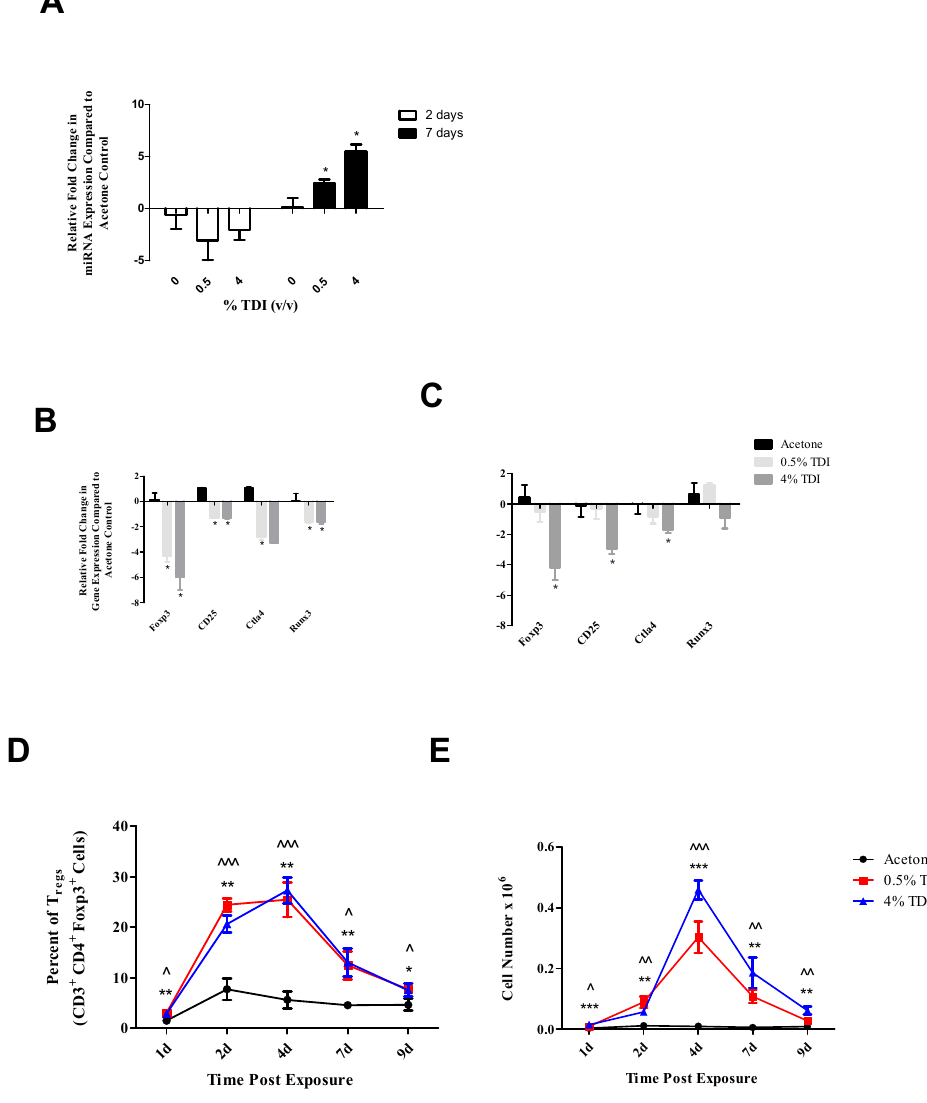
Figure 4. Mature miRNA and Runx3 expression increases in T regs during TDI sensitization. RT ‐ PCR analysis of miR ‐ 210 ( A ) and T reg ‐ related gene expression in the dLN T reg subset at two ( B ) and seven days ( C ) post TDI exposure. T regs were isolated as CD4 + CD25 + cells and cellular purity was assessed via flow cytometric staining for CD3 + CD4 + Foxp3 + events (2 days: % T regs of all CD4 + events, mean, n = 4–5 per group: Acetone: 83.8% ± 1.6%, 0.5% TDI: 67.1% ± 4.2%, and 4% TDI: 72.3% ± 1.9%; 7 days: % T regs of all CD4 + events: Acetone: 91%, 0.5% TDI: 88.4%, and 4% TDI: 86.7%). Flow cytometric analysis of dLN Runx3 + T reg frequency ( D ) and number ( E ) following TDI sensitization. Bars represent mean relative fold change (±SE) of 4–5 mice per group. Significance is indicated by * p ≤ 0.05 for ( A – C ) and p ≤ 0.05 (*), p ≤ 0.01 (**), p ≤ 0.001 (***), and p ≤ 0.0001 (****) for 4% TDI or p ≤ 0.05 (ˆ), p ≤ 0.01 (ˆˆ), p ≤ 0.001 (ˆˆˆ), and p ≤ 0.0001 (ˆˆˆˆ) for 0.5% TDI compared to vehicle control ( D , E